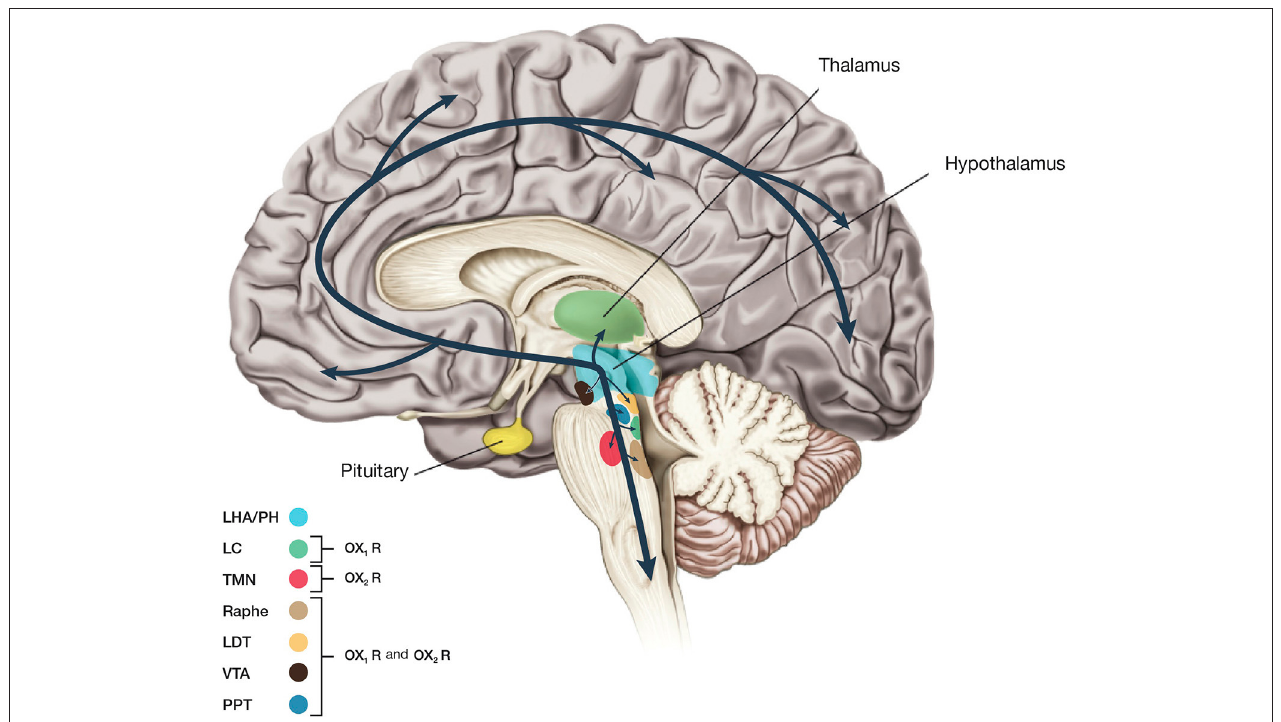
FIGURE 4 | Input and output of orexin neurons at interface of sleep, stress, reward, and energy homeostasis. Orexin neurons in the lateral hypothalamic area (LHA) and posterior hypothalamus (PH) are placed to provide a link among limbic system, energy homeostasis, brainstem and other systems. Arrows show excitatory projections and broken arrows inhibitory projections. Gray semicircles indicate OX1R and black semicircles indicate OX2R. Neurotransmitters/modulators are underlined. LC, DR, and TMN are wake-active regions, VLPO is sleep-active region, and LDT/PPT is REM-active region. Orexin neurons promote wakefulness through monoaminergic nuclei that are wake-active. Stimulation of dopaminergic centers by orexins modulates reward systems (VTA). Peripheral metabolic signals influence orexin neuronal activity to coordinate arousal and energy homeostasis. Stimulation of neuropeptide Y neurons by orexin increases food intake. The SCN, the central body clock, sends input to orexin neurons via the DMH. Input from the limbic system (amygdala and BST) might be important to regulate the activity of orexin neurons upon emotional stimuli to evoke emotional arousal or fear-related responses. Abbreviations: BST, bed nucleus of the stria terminalis; VLPO, ventrolateral preoptic area; LC, locus ceruleus; DR, dorsal raphe; TMN, tuberomammillary nucleus; LDT, laterodorsal tegmental nucleus; PPT, pedunculopontine tegmental nucleus; VTA, ventral tegmental area; SCN, suprachiasmatic nucleus; DMH, dorsomedial hypothalamus; Arc, arcuate